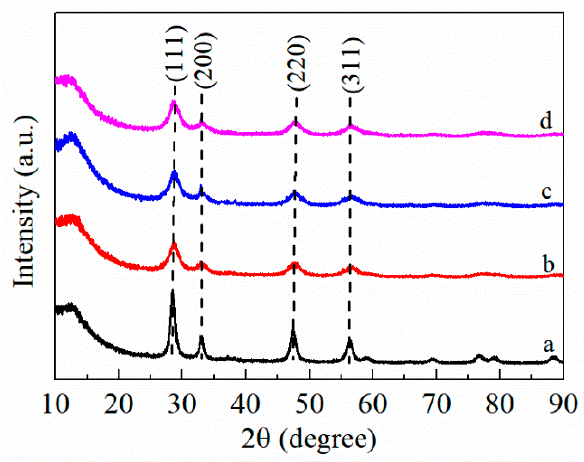
Figure 3. XRD patterns of ( a ) MnO 2 -CeO 2 , ( b ) FMC-1:5:5, ( c ) FMC-2:5:5 and ( d )